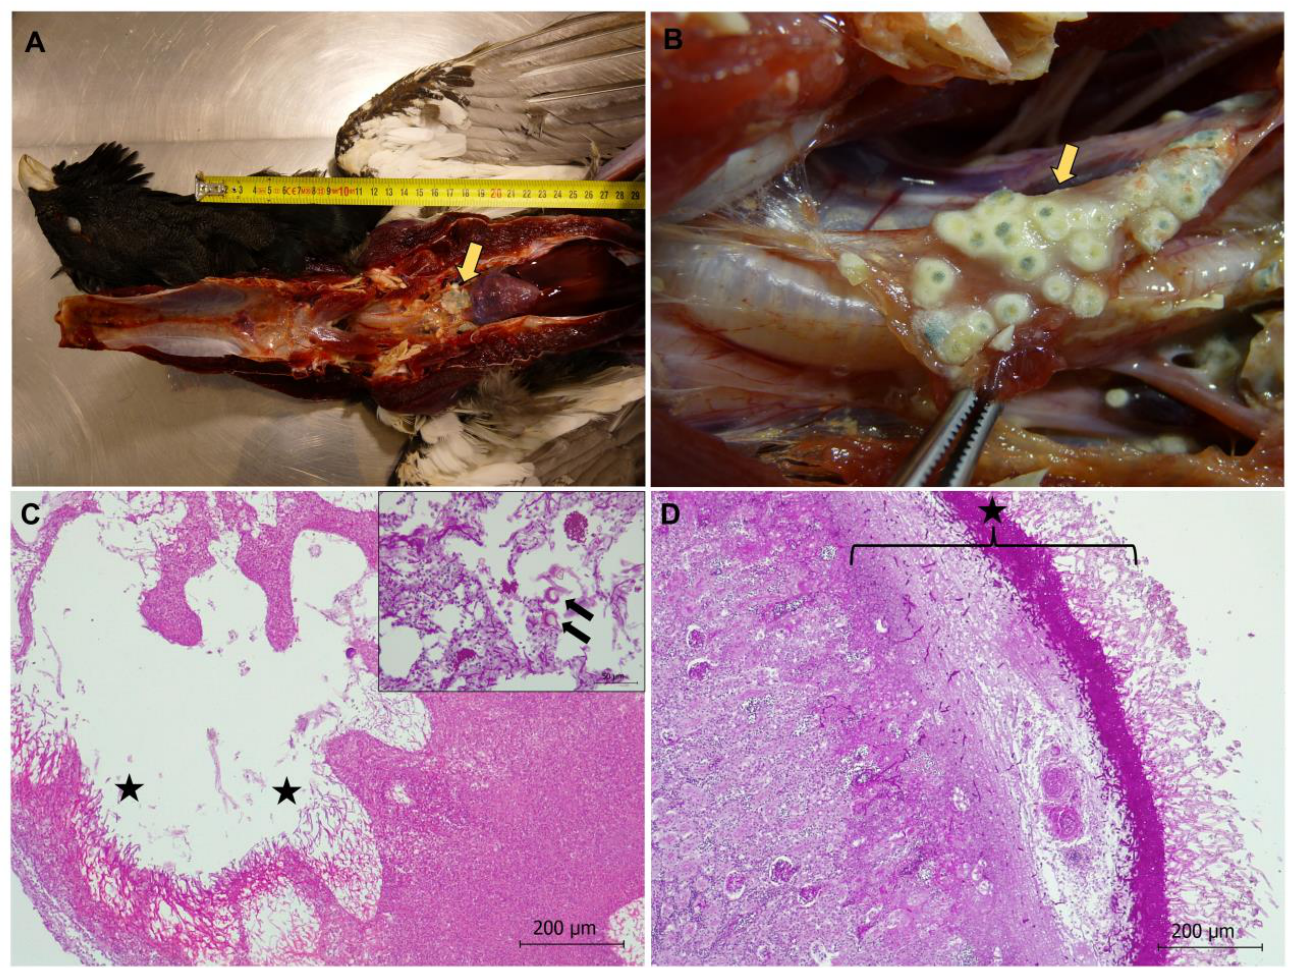
Figure 3. Aspergillosis in a Cantabrian capercaillie. ( A ) Gross lesion (arrow) due to Aspergillus fumigatus in a capercaillie. ( B ) Numerous nodules (greenish-white granulomas, arrow) in air sacs of a capercaillie with acute aspergillosis are observed. ( C ) Lung. Severe pneumonia is observed, with a parabronchus containing numerous, dichotomously branched, septate fungal hyphae (stars), dis- closed using PAS staining. Inset: Conidiophores (arrows) are seen in this severe pulmonary infection. PAS stain. ( D ) Kidney. Granulomatous nephritis with numerous hyphae and few conidiophores in the renal cortex (star) are observed. PAS stain.